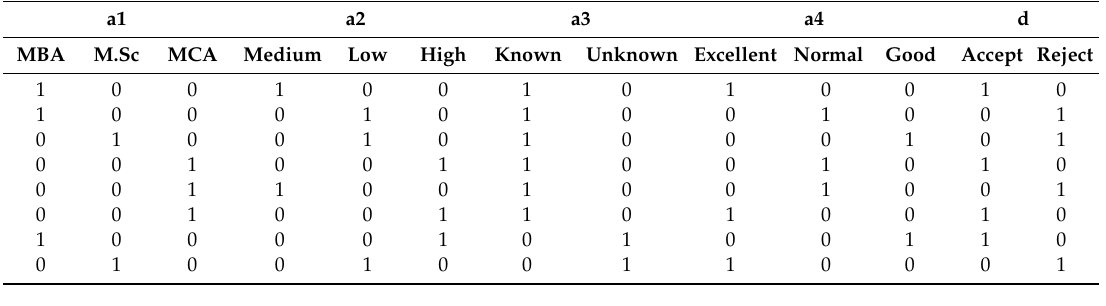
Table 2. Multi-value information